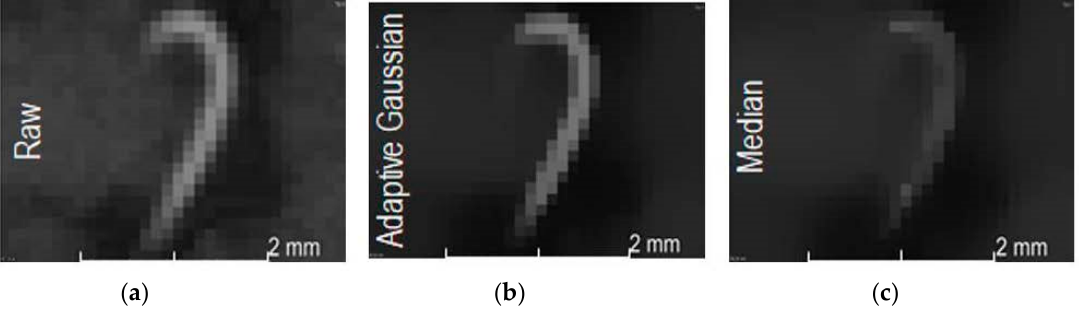
Figure 2. 2D slices showing ( a ) a raw version ( b ) the effect of the adaptive Gaussian and ( c ) median filters on the image of one fiber.